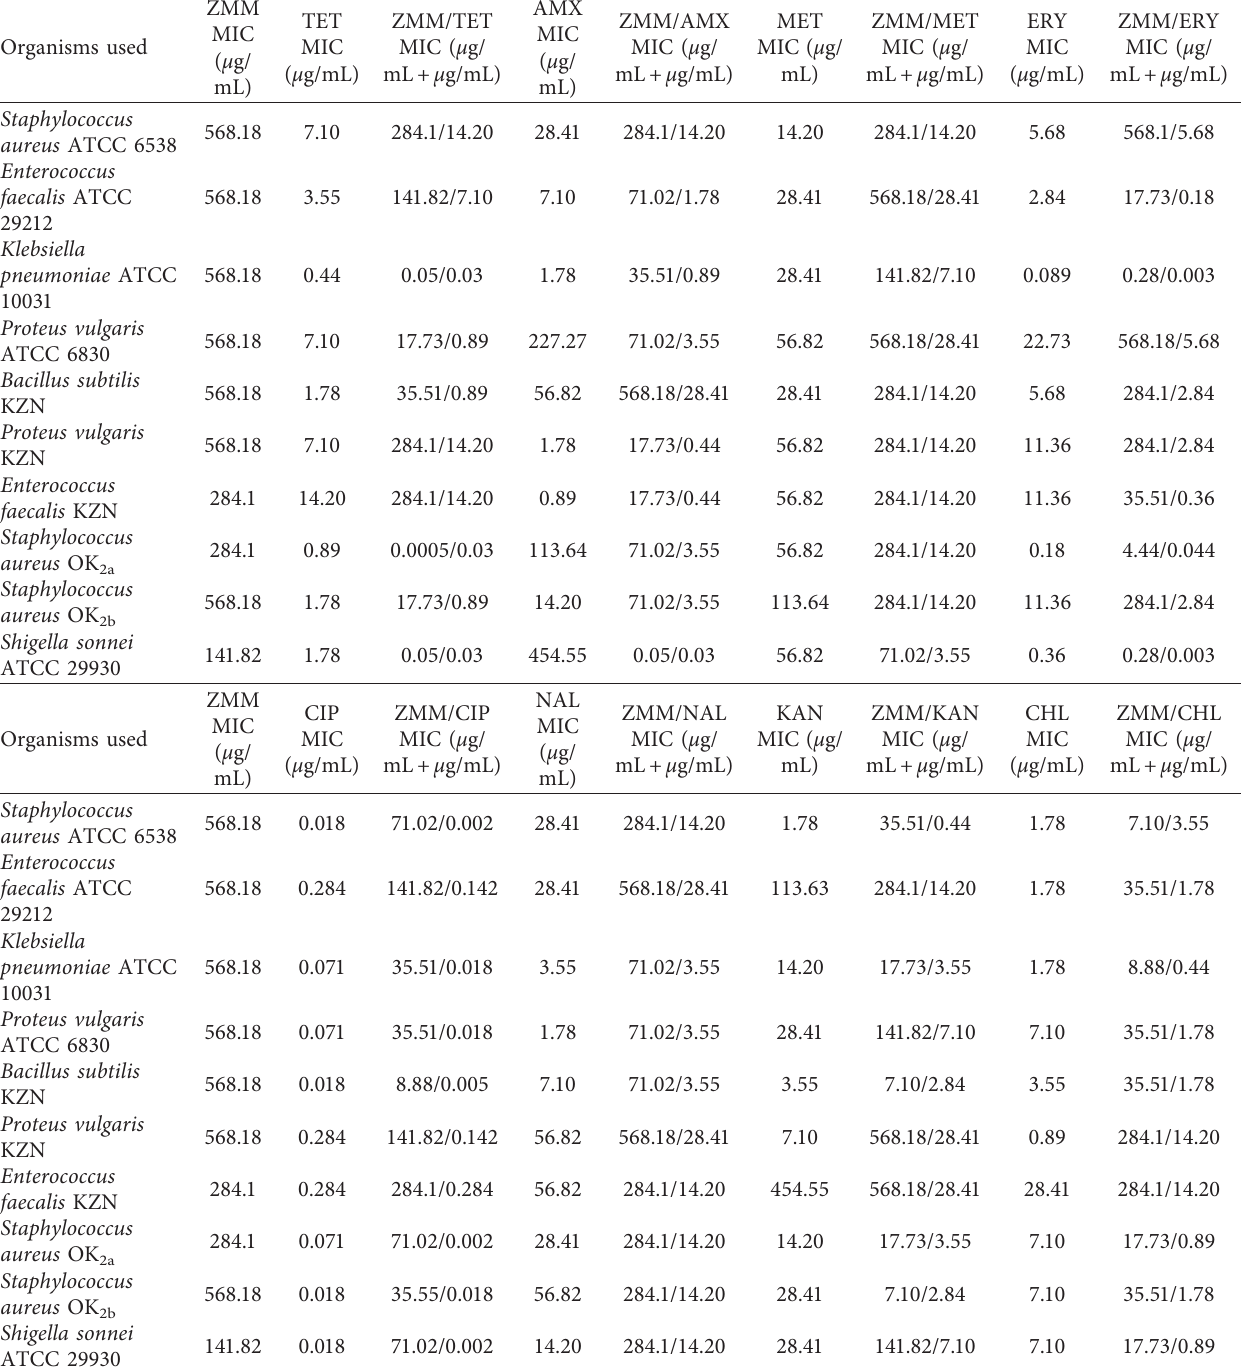
Table 4: Antibacterial and effects of combining methanolic extract of Z. mucronata with different antibiotics in vitro . Organisms